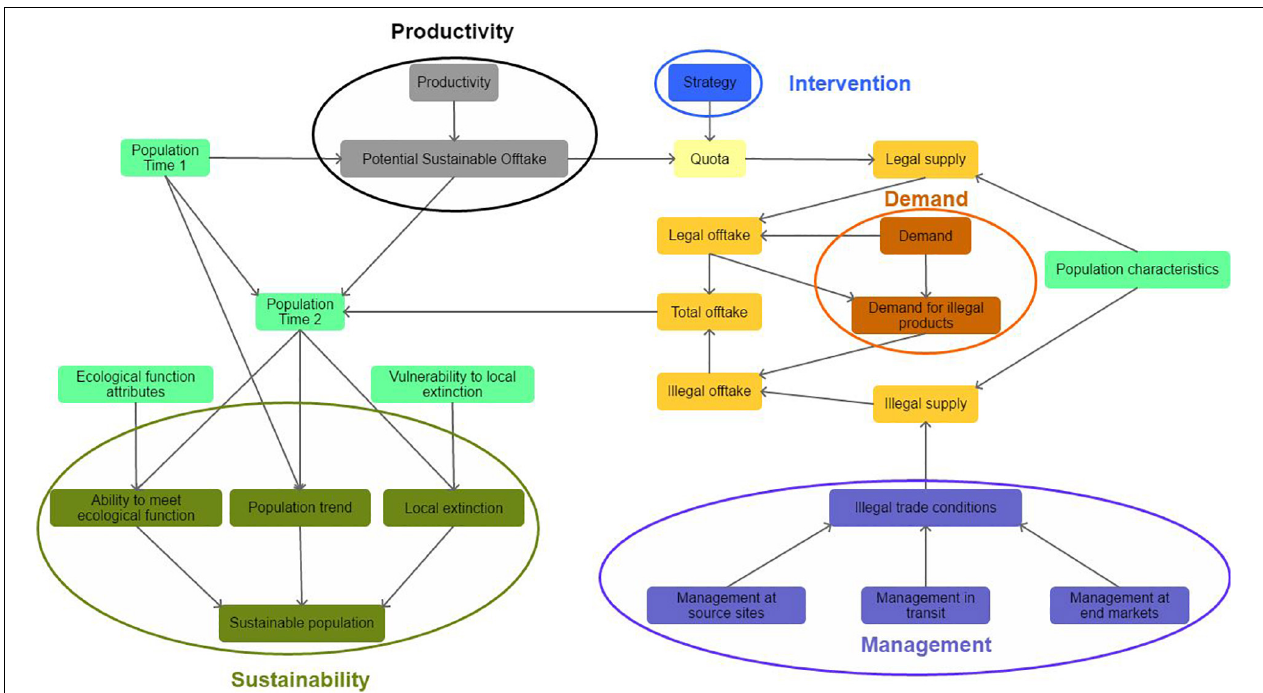
FIGURE 3 | BBN representing the relationships between productivity, demand and management on the sustainability of the population. Nodes describing biological characteristics are colored bright green and nodes colored bright yellow describe supply and